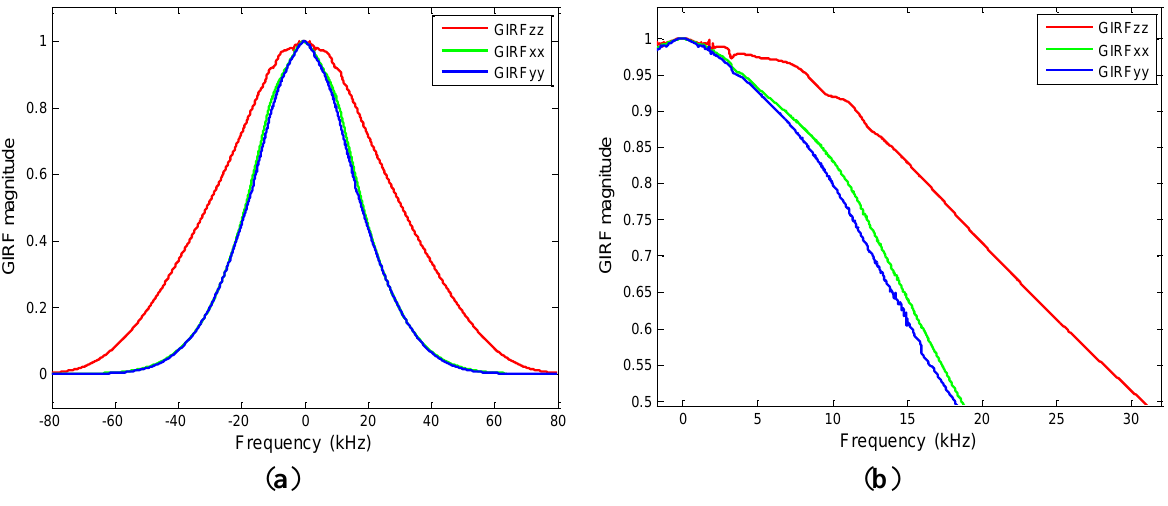
Figure 2. Plots of gradient impulse response function (GIRF) magnitude and phase for the three gradient directions. ( a – c ) Increasingly zoomed plots of GIRF magnitude. The overall frequency response is apparent in ( a ), while more detail, including mechanical resonances are apparent in ( b ) and ( c ). While the magnitude GIRFs for the x and y gradients closely follow each other, the z gradient exhibits a rather higher frequency